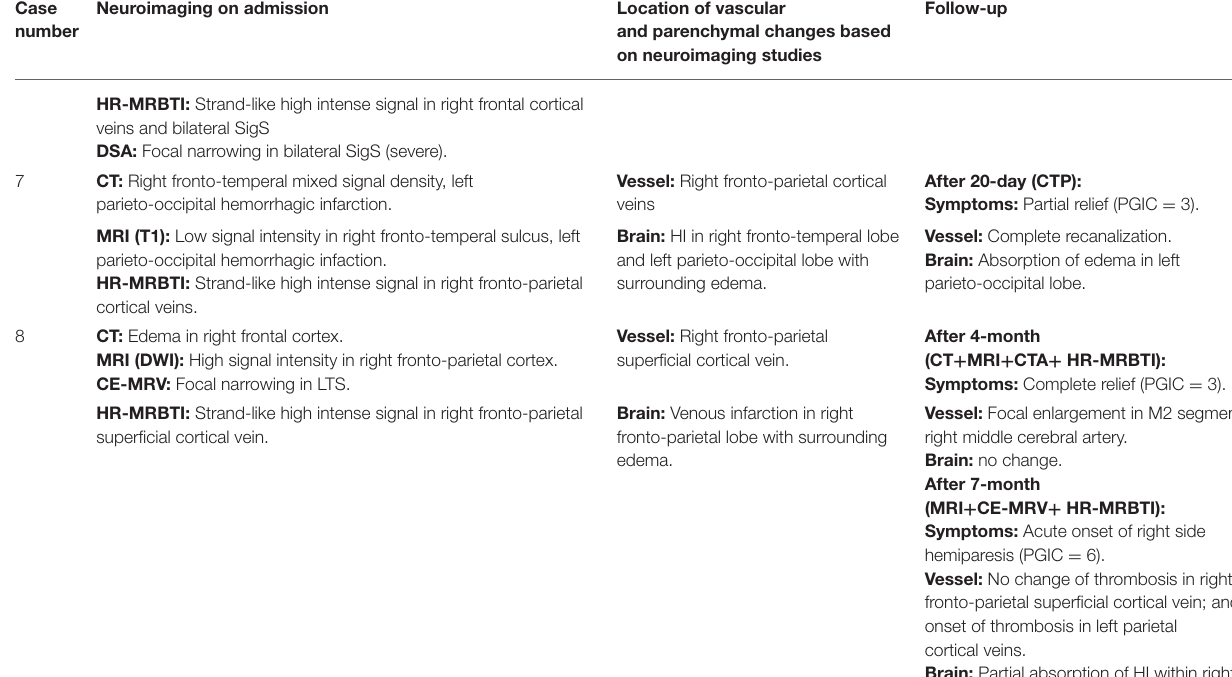
Location of vascular and parenchymal changes based on neuroimaging studies